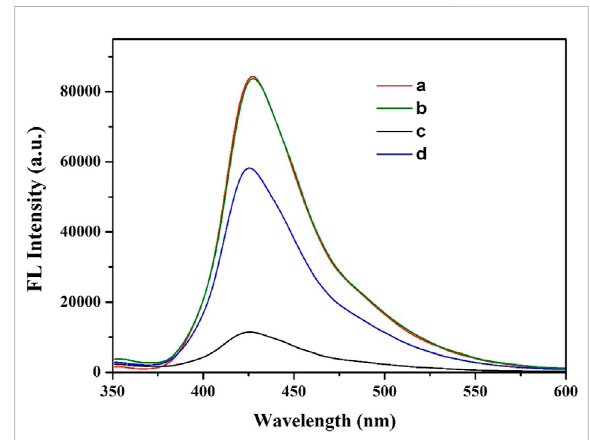
FIGURE 3 Schematic illustration of fl uorescence sensor for glyphosate detection via CN NNS.